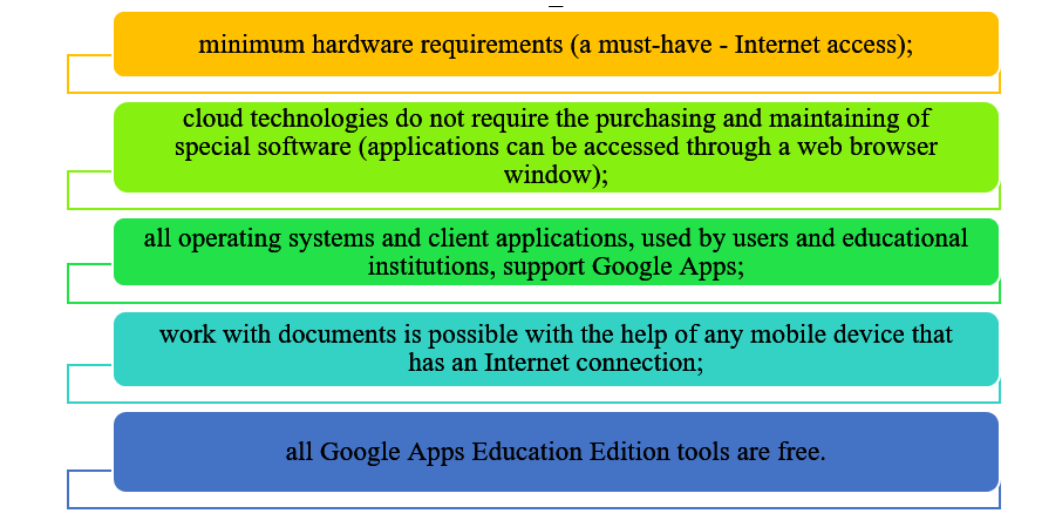
Figure 69: Presentation of paper [309].